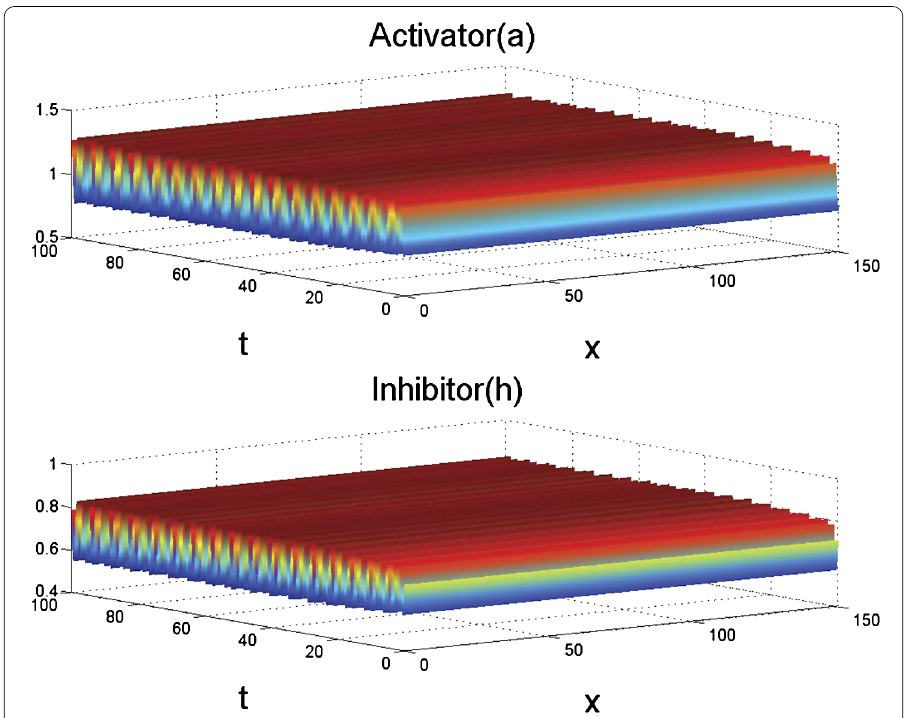
Figure 11 The stable limit cycle of (5) is still stable for (3)